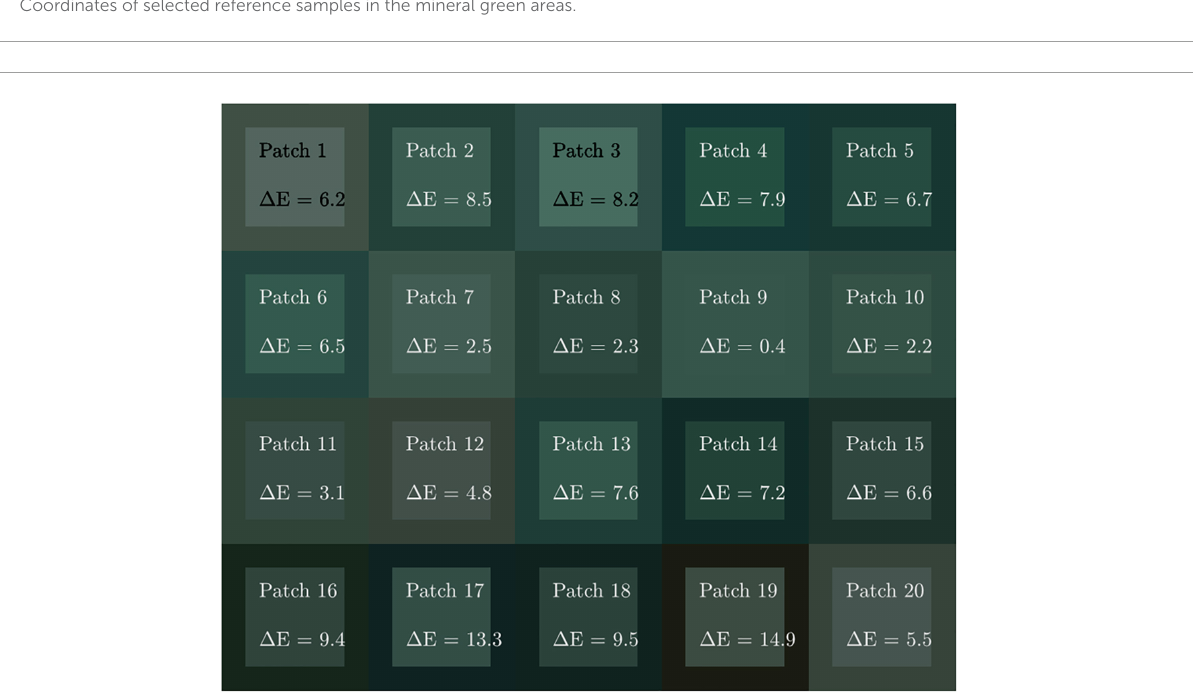
FIGURE10 Color patch diagram of the original and corrected